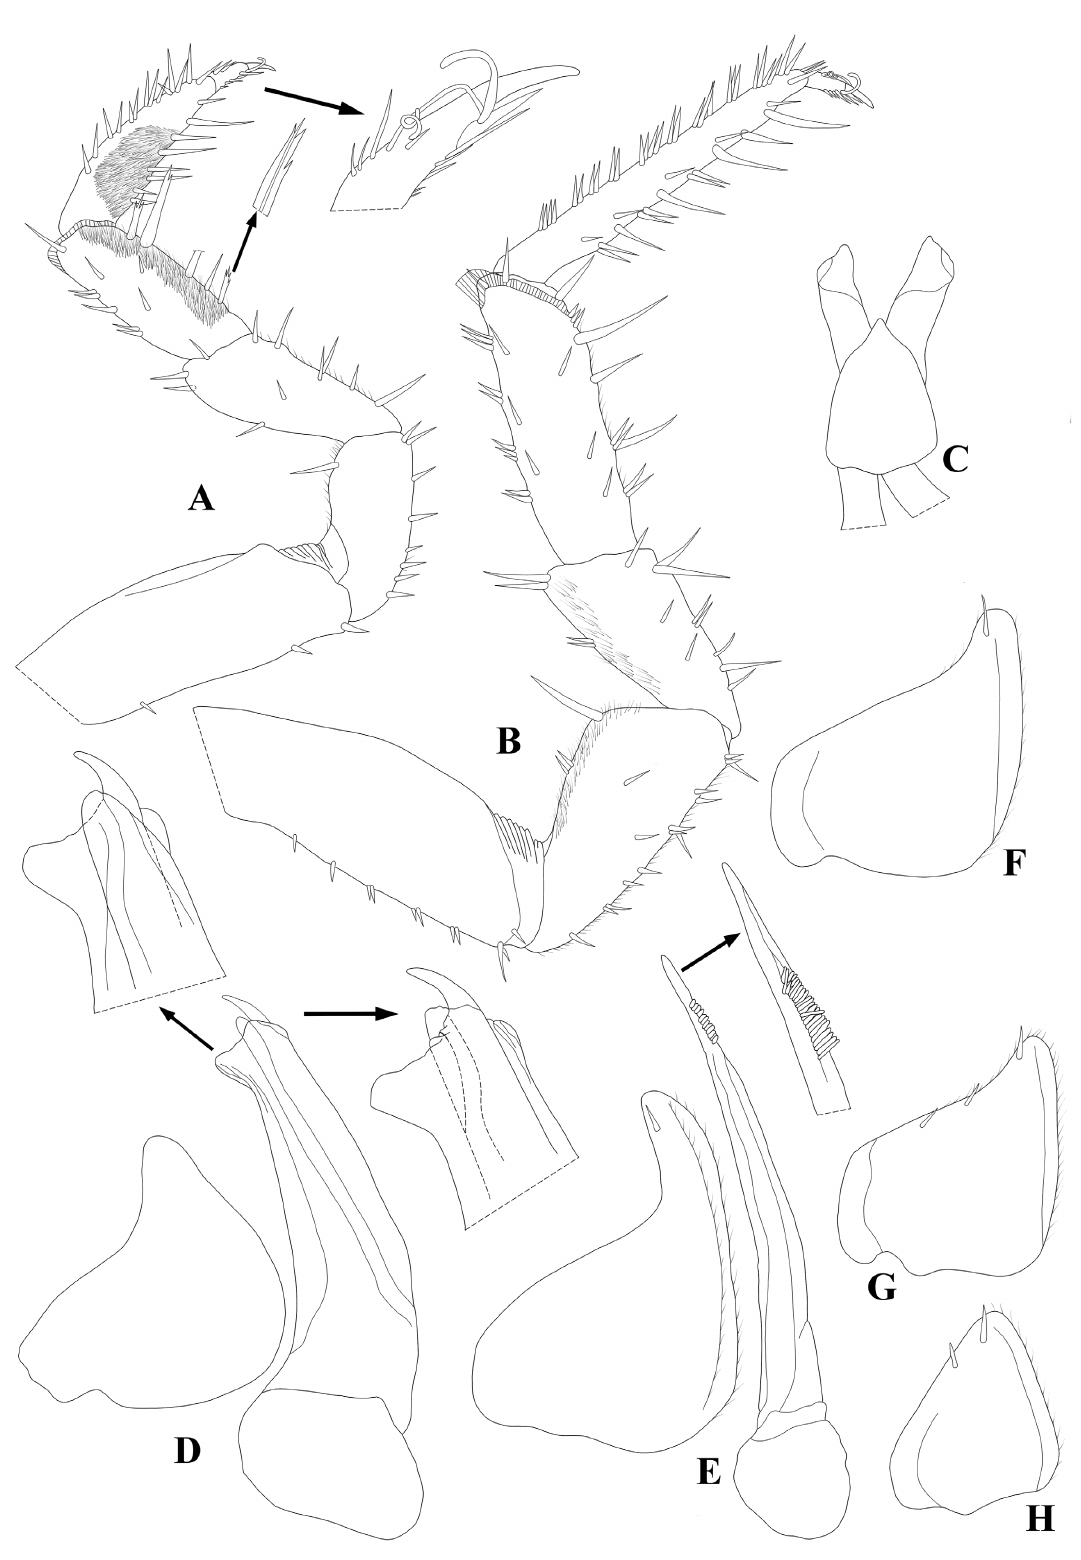
Fig. 17. Halophiloscia trichoniscoides (Vandel, 1973) comb. nov., ♂ (MZUF 9607). A . Pereopod 1. B . Pereopod 7. C . Genital papilla. D . Pleopod 1. E . Pleopod 2. F . Pleopod 3 exopod. G . Pleopod 4 exopod. H . Pleopod 5